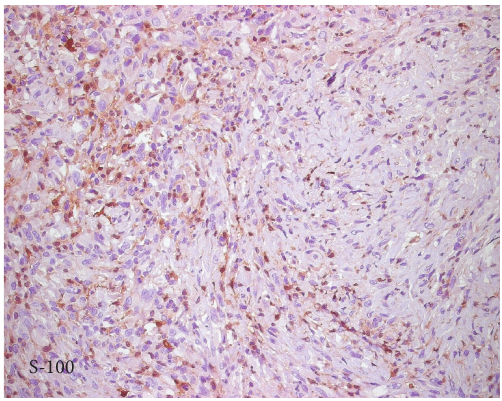
Figure7:Immunohistochemistryprofileshowsmildfocalpositivity for